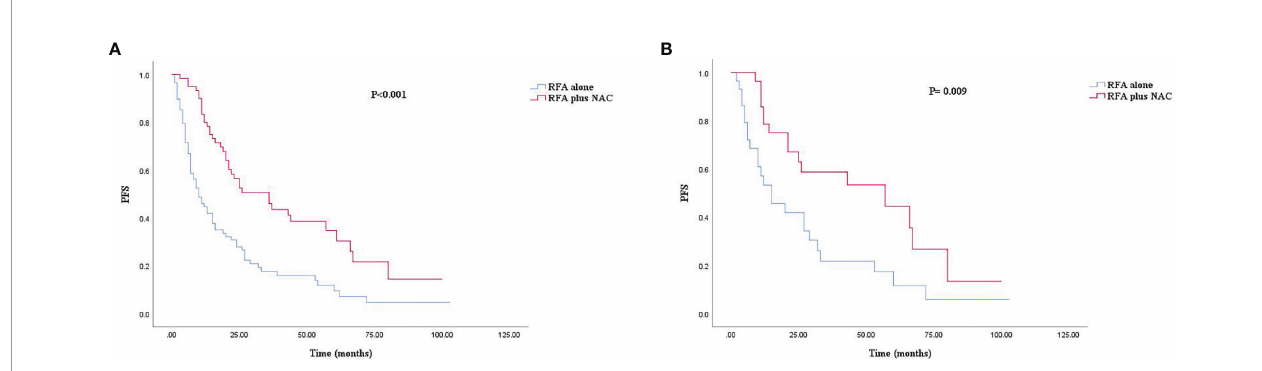
FIGURE 2 | Kaplan – Meier survival curve for PFS of the RFA alone and plus NAC groups. (A) Unmatched analyses and (B) propensity-score-matched